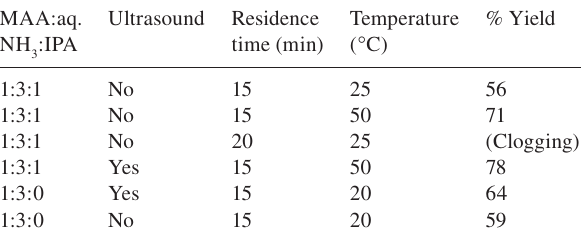
Table 2 Summary of continuous experiments for the synthesis of β -amino crotonates following the non-catalytic route in the presence of solvent isopropanol (IPA).